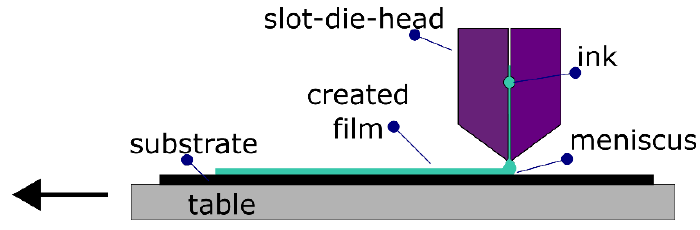
Figure 1. Scheme of slot-die-coating